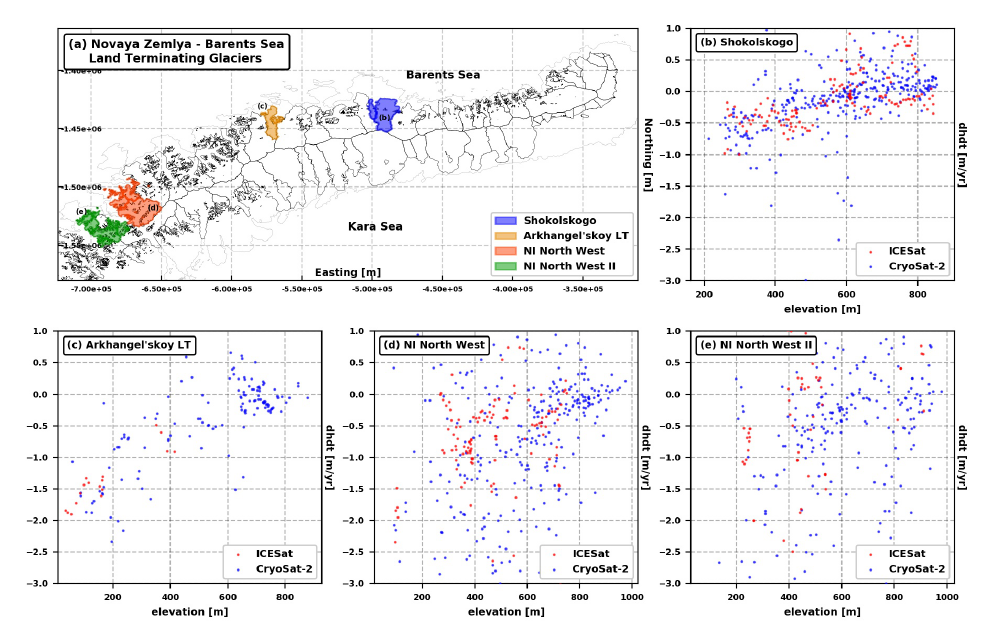
Figure 8. Elevation vs. Elevation Changes calculated for the major land-terminating glaciers facing the Barents Barents calculated using ICESat and CryoSat-2. ( a ) Novaya Zemlya Glaciers, ( b ) Shokolskogo, ( c ) Arkhangel’skoy LT, ( d ) NI North West, ( e ) NI North West II.